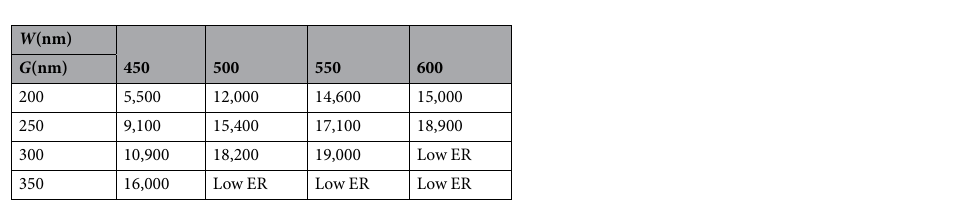
Figure 4. ( a ) Measured transmission spectrum, ( b ) quality factor and ( c ) waveguide group index (blue circles) and dispersion (red solid line) of the quasi – TE mode of a silicon rich nitride ring resonator, with R = 50 µ m, W = 450 nm, H = 400 nm, G = 200 nm.